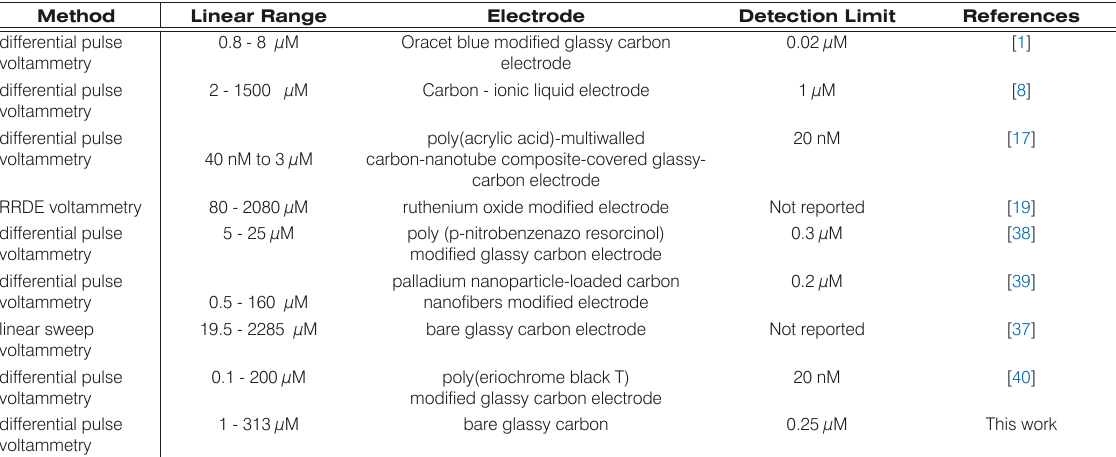
Table 5. Comparison of the linear range and detection limit with previous